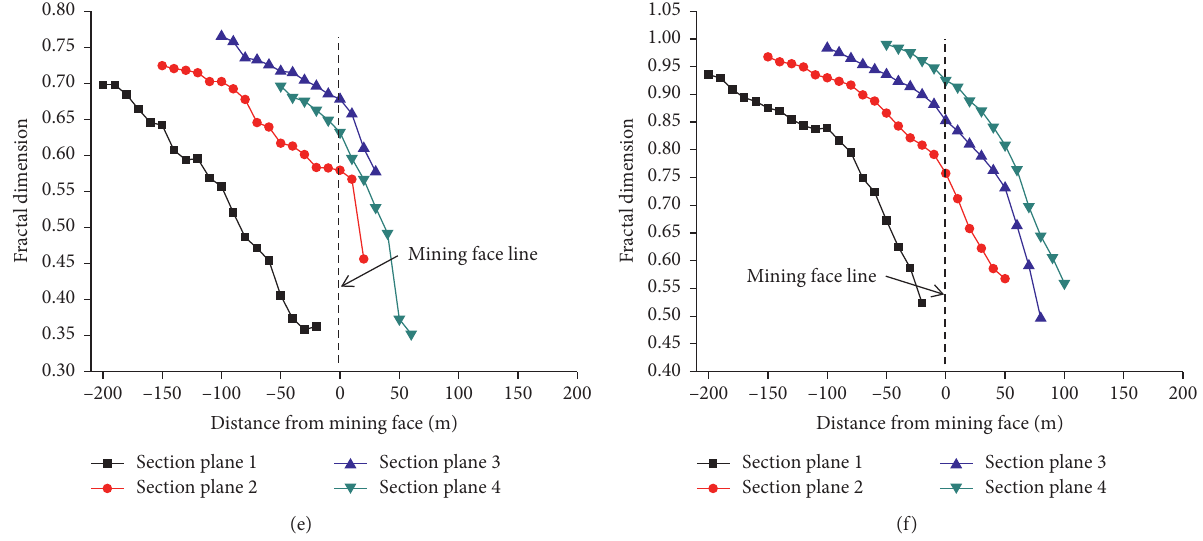
Figure 11: Evolution of the fractal dimension of the fractures in the overburden strata in the vertical section planes: (a) pebbly sandstone; (b) siltstone; (c) mudstone; (d) medium sandstone 1; (e) fine sandstone; (f) medium sandstone 2.